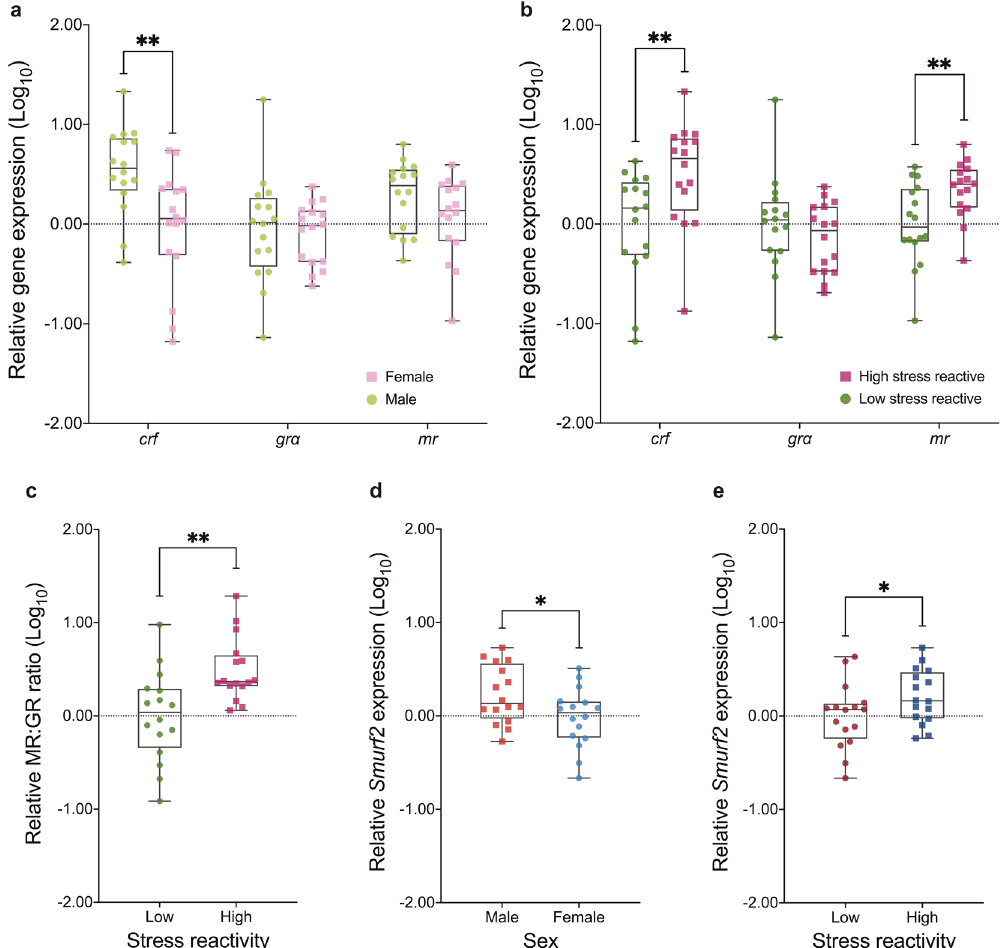
Figure 3. Analysis of HPI axis-associated gene expression within brain extracts by qPCR validates behaviourally determined stress reactivity. qPCR analysis of the HPI axis-associated genes, corticotropin- releasing factor ( crf ), glucocorticoid receptor α ( grα ) and mineralocorticoid receptor (mr) in association with zebrafish ( a ) sex and ( b ) stress reactivity ( N = 96). ( c ) Stress reactivity had a significant effect on the MR:GR ratio, a key indicator of HPA axis dysfunction ( N = 32). The expression of SMAD Specific E3 Ubiquitin Protein Ligase ( smurf2 ) was also analysed through qPCR and was significantly associated with both ( d ) sex and ( e ) stress reactivity ( N = 32). Box plots indicate median values (middle lines), first and third quartiles (box edges) and minimum and maximum values (whiskers). *p-value < 0.05; ** p -value <